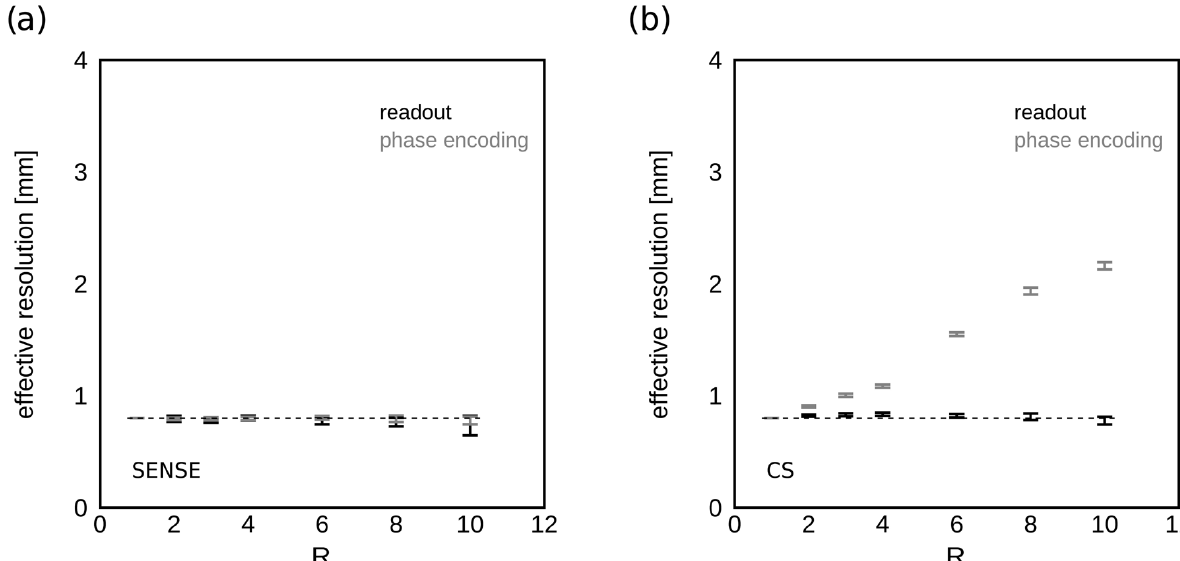
Figure 6. Spatial resolution as a function of R . The dependence of effective spatial resolution in the ( a ) SENSE- and ( b ) CS-accelerated HiSS MRI WPH images on the acceleration factor R is shown for the readout and phase encoding directions. The dashed lines indicate the nominal spatial resolution of 0.8 mm in each direction. SENSE acceleration preserves spatial resolution. For CS, the loss of resolution in the phase encoding direction is noticeable, up to a factor of 2.7 for 10-fold acceleration.